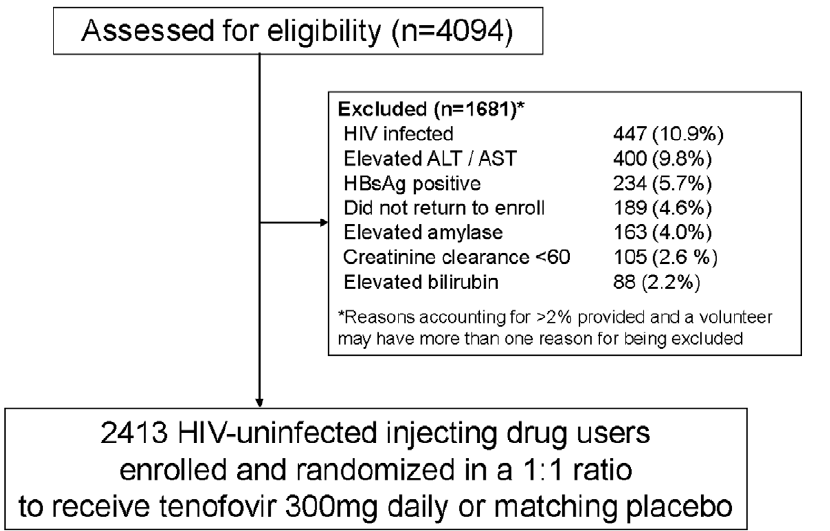
Figure 1. Number of injection drug users screened and enrolled in the Bangkok Tenofovir Study in Bangkok, Thailand, 2005–2010.